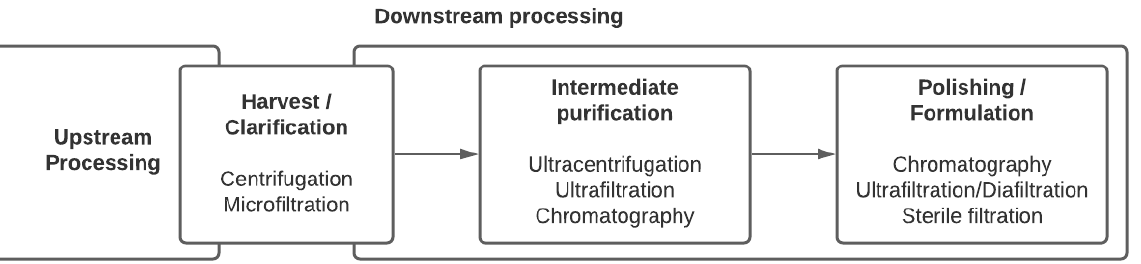
Figure 2. General sequence of viral vector and viral vaccine production bioprocesses.